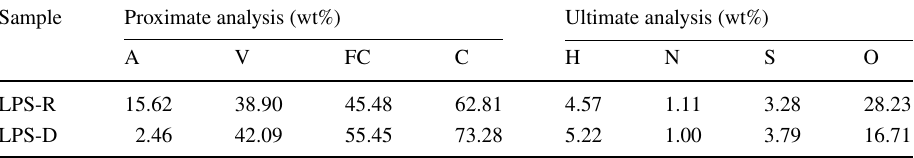
Sample Proximate analysis